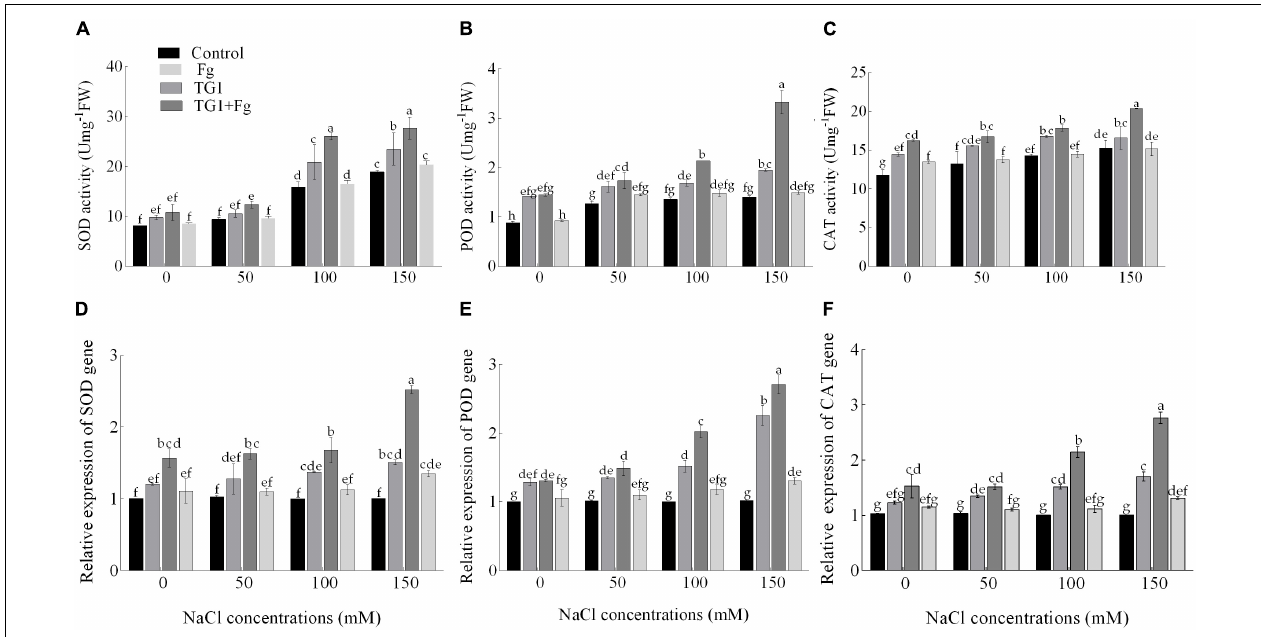
FIGURE 8 | Effect of T. longibrachiatum (TG1) on SOD (A) , POD (B) , and CAT (C) activities and relative expressions of SOD (D) , POD (E) , and CAT (F) genes in the root of wheat seedlings under F. pseudograminearum (Fg) and different salt stress at 28 days after inoculation. Small bars represent the standard errors of the means. Different lower case letters indicate significant differences at P < 0.05 in Duncan’s multiple range test using two-way ANOVA. The treatments are detailed in the footnote of Figure 5